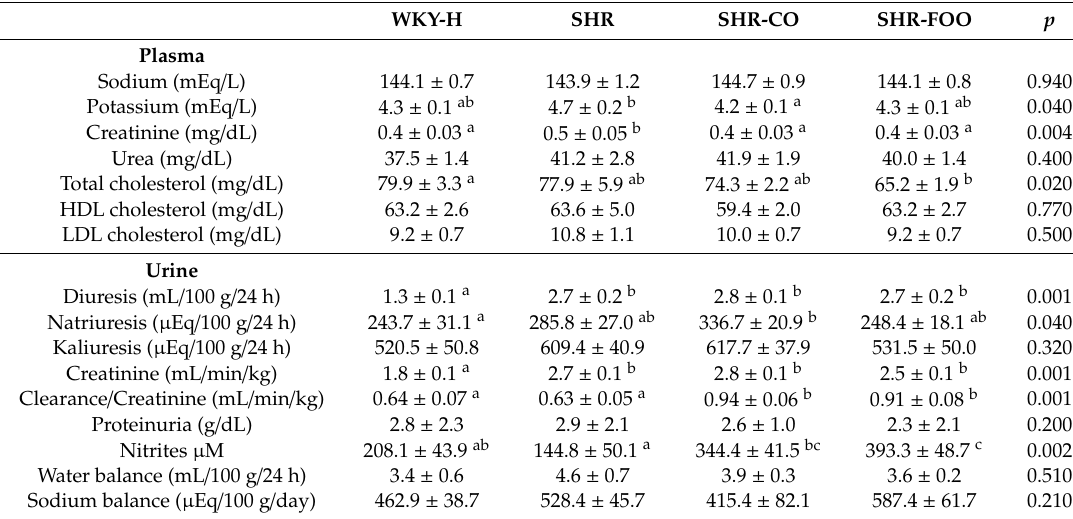
Table 3. Plasma and urine biochemical variables in the experimental groups after eight weeks of intervention.